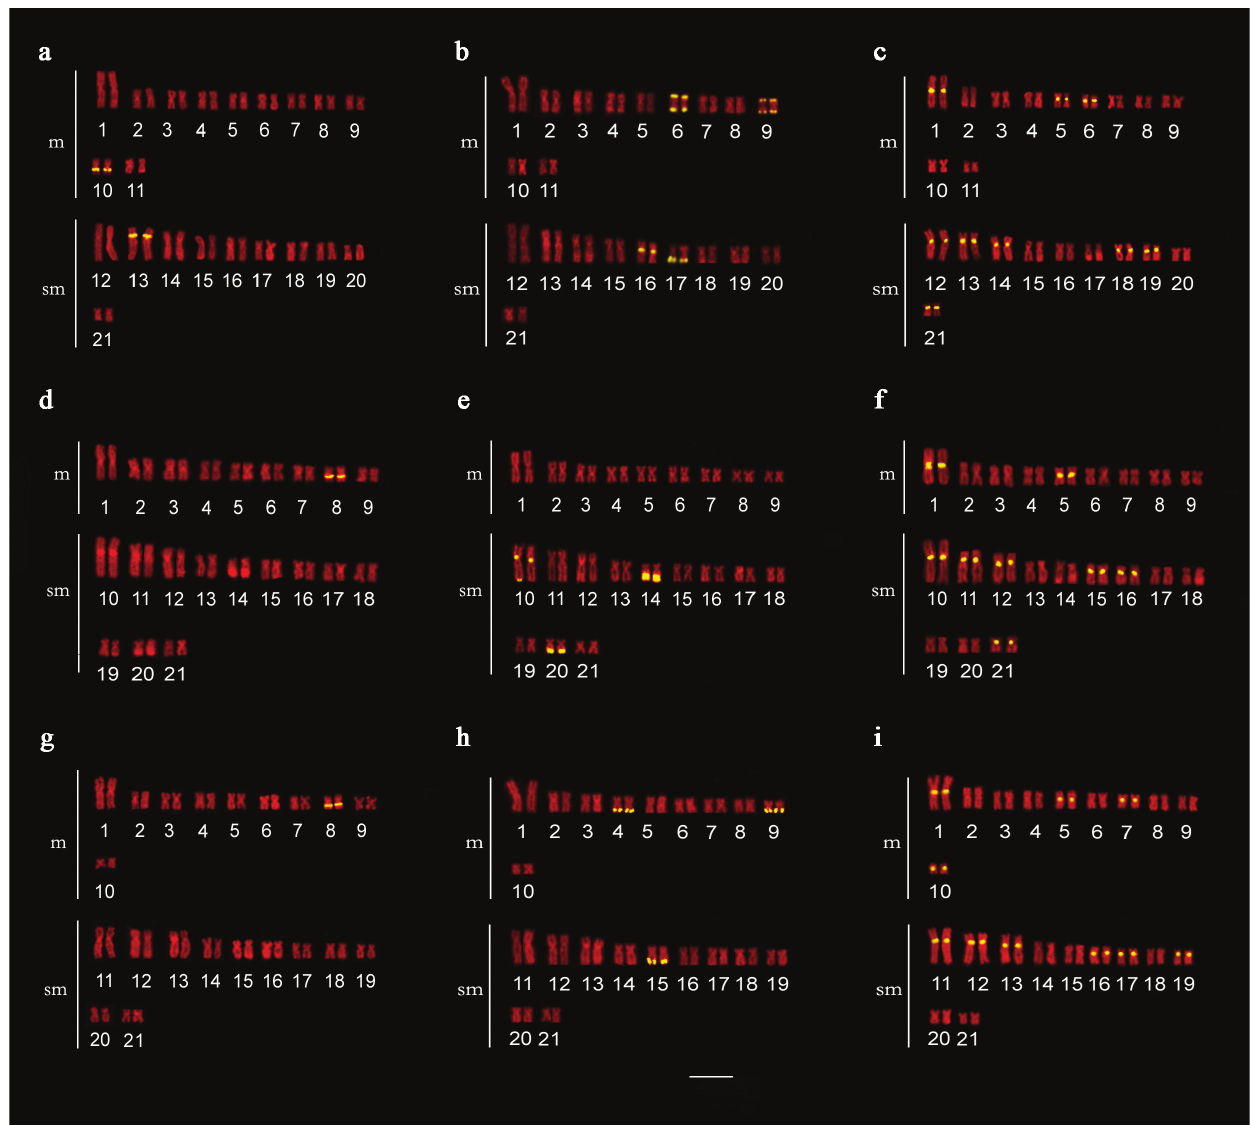
18S rDNA ( b , e , h ) and 5S Hind III satellite DNA ( c , f , i ) probes in the populations from the basins of the São Francisco ( a , b , c ), Araguaia ( d , e , f ) and Xingu ( g , h , i ) Rivers. Scale bar = 5 μ